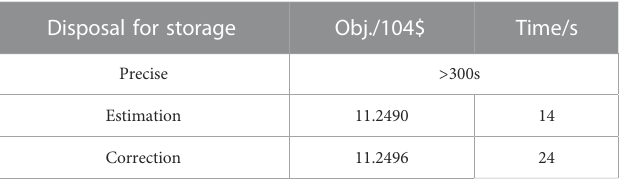
TABLE 6 Optimization results with different strategies for the state variables of energy storages.